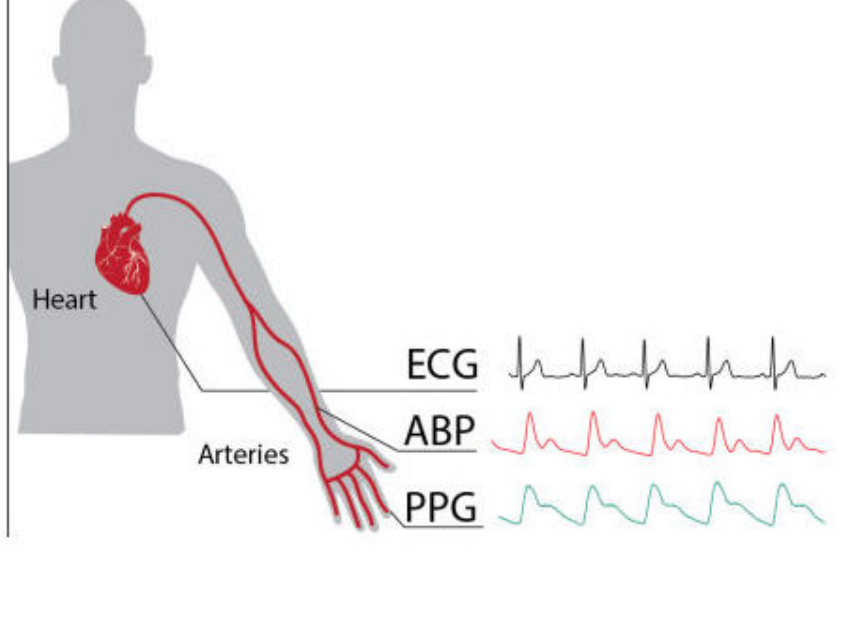
Figure 1. Visualized relation between electrocardiography (ECG), arterial blood pressure (ABP), and photoplethysmography